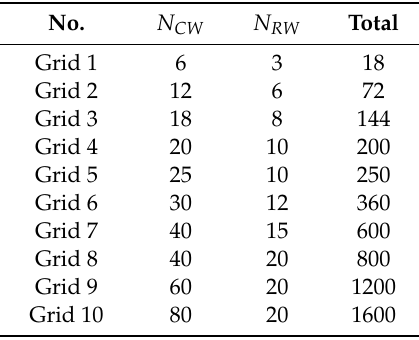
Table 2. Number of cells included at each grid level used for convergence